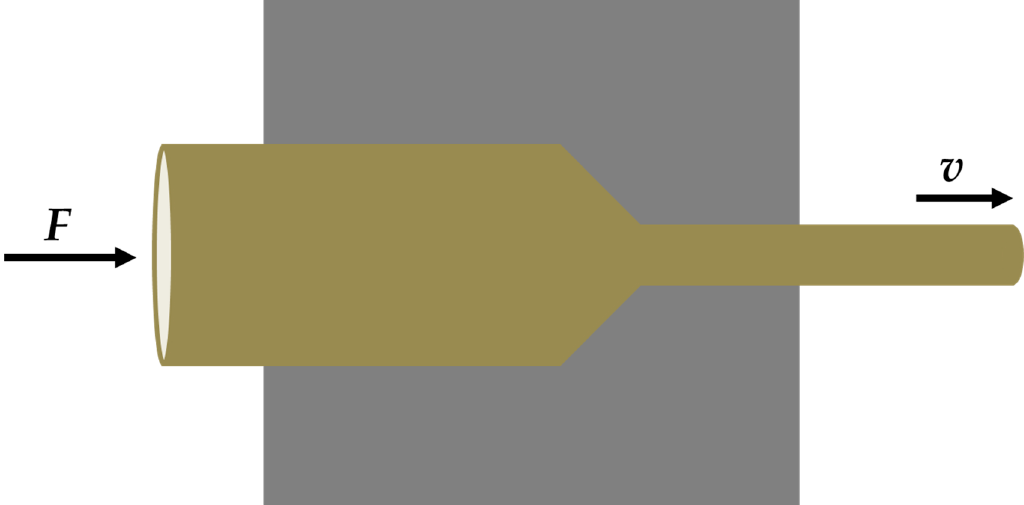
Figure 1. Schematic diagram of the extrusion process.